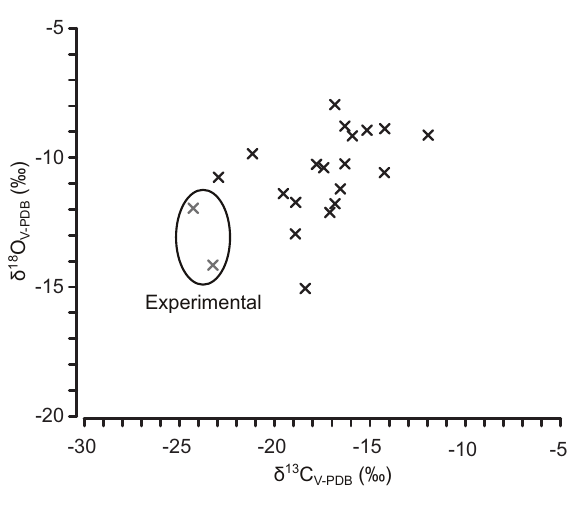
Fig. 2. Carbon and oxygen stable isotope composition of ash